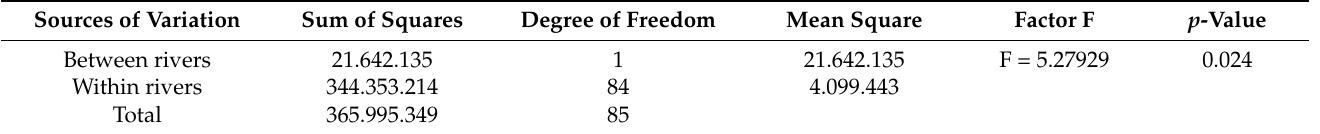
Table A3. ANOVA test between Spanish and French